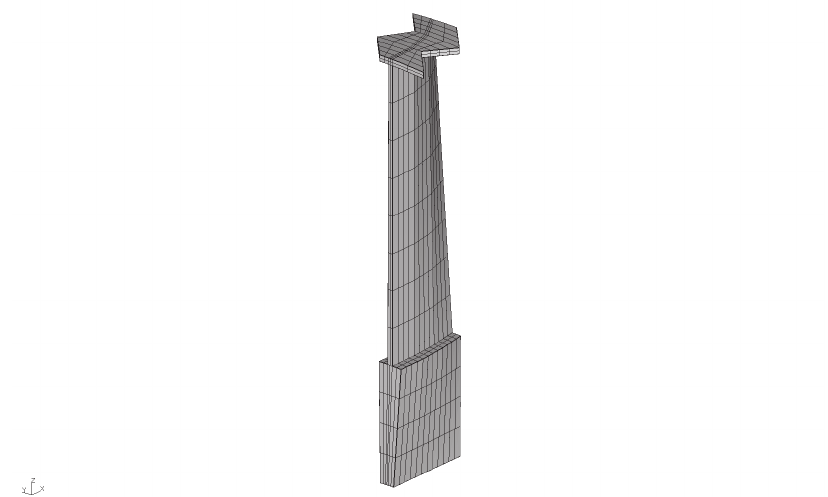
Figure 4: Mesh of the engine blade.